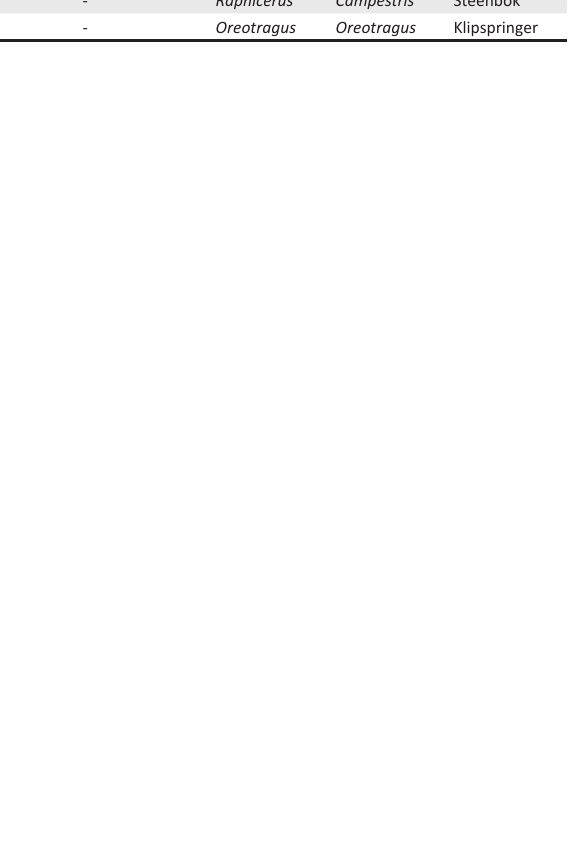
Table 1-A1 continues on the next column →